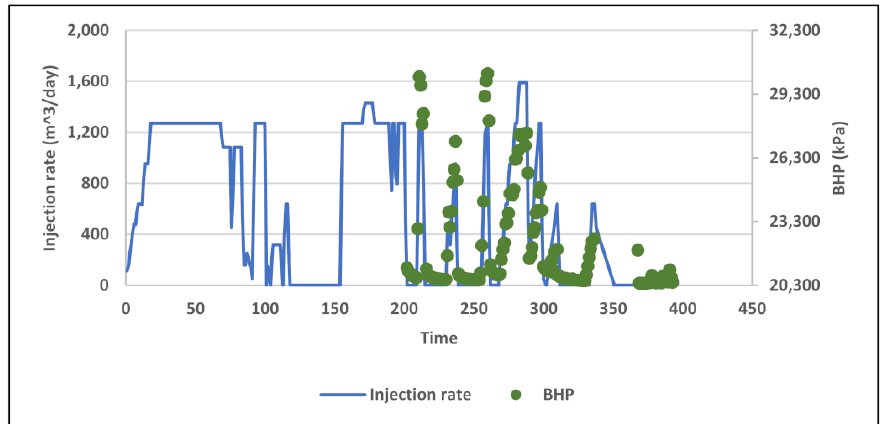
Figure 15. Field data of injection rates and BHP during water injection